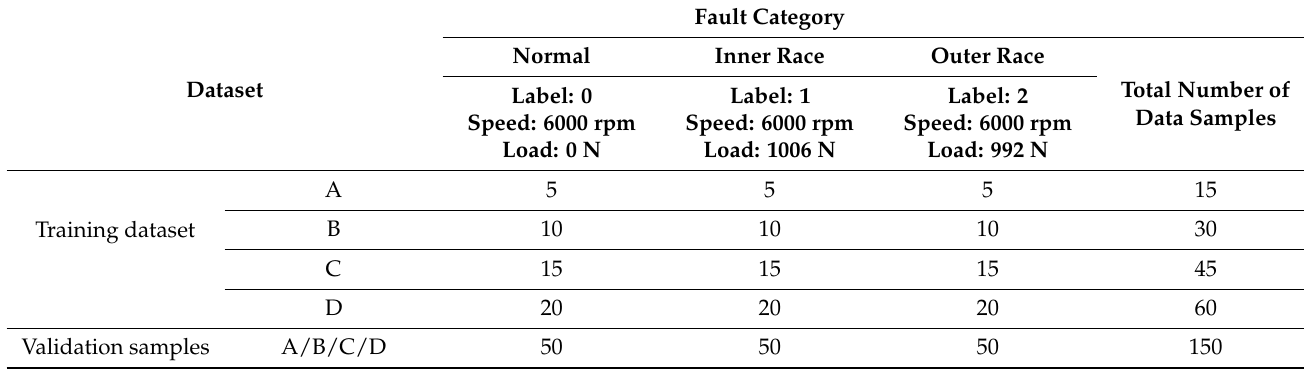
Table 1. The training/validation data statistics of rolling bearing.